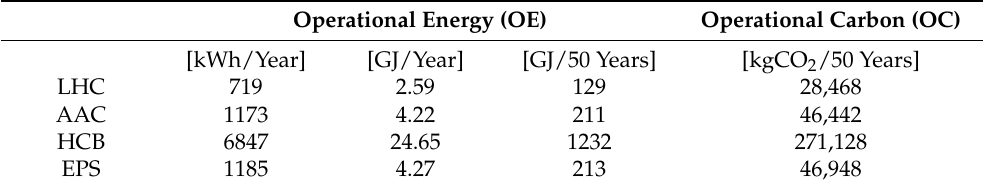
Table 4. Calculations of the building’s OE and OC, based on